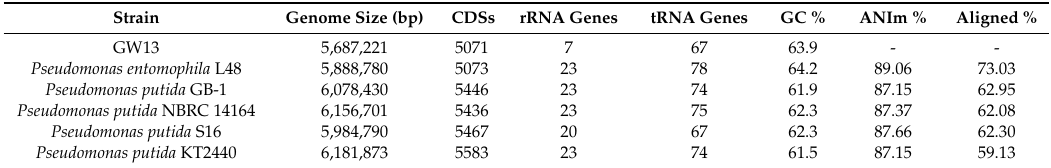
Table 2. Genomic characteristics of GW13 and other reference strains in EzBioCloud. Strain Genome Size (bp) CDSs rRNA Genes tRNA Genes GC % ANIm % Aligned%